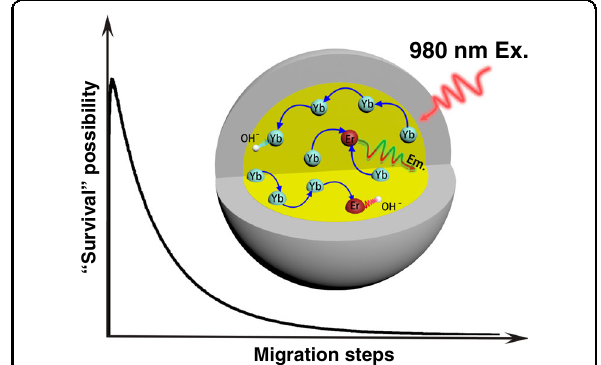
Scheme 1 Schematic diagram of the internal OH − in fl uences on energy migration-induced UCL, which can be visualized as “ survivor effect. ” Typically, the shorter the migration path of an excited state of Yb 3 + , the larger the possibility of its surviving from OH − -induced